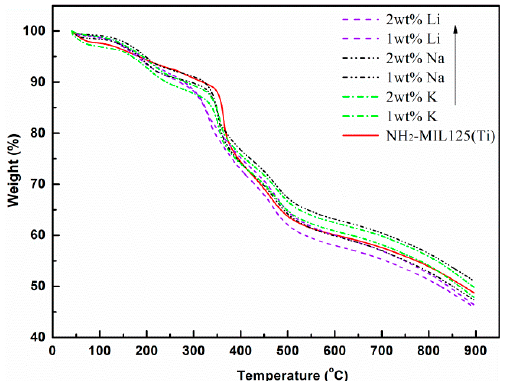
Figure 4. Thermogravimetric analysis (TGA) curves of NH 2 –MIL125(Ti) and x M@NH 2 –MIL125(Ti).